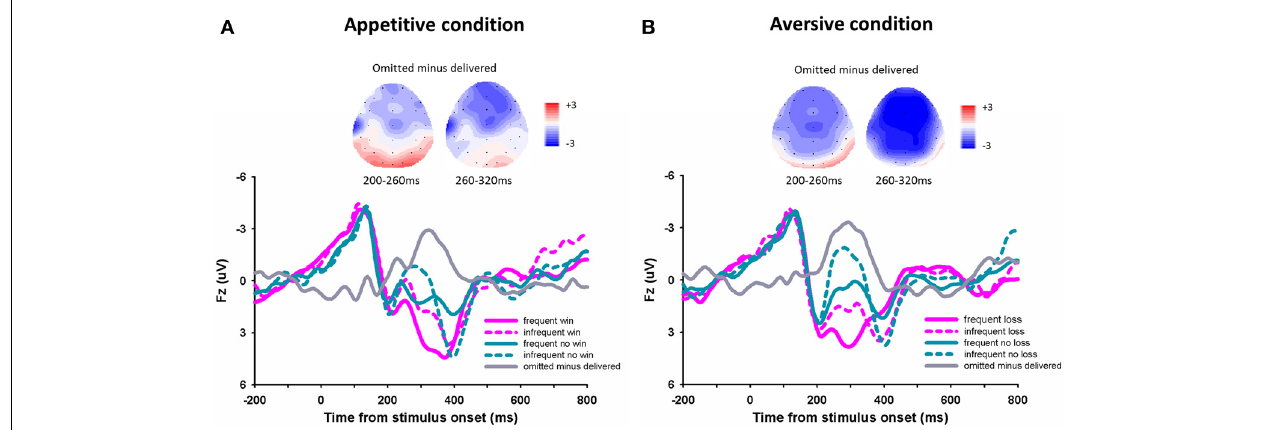
FIGURE 3 | The ERP grand-average waveforms and topographical maps. Grand-average waveforms and different waveforms at channel Fz for the appetitive condition (A) and the aversive condition (B) .